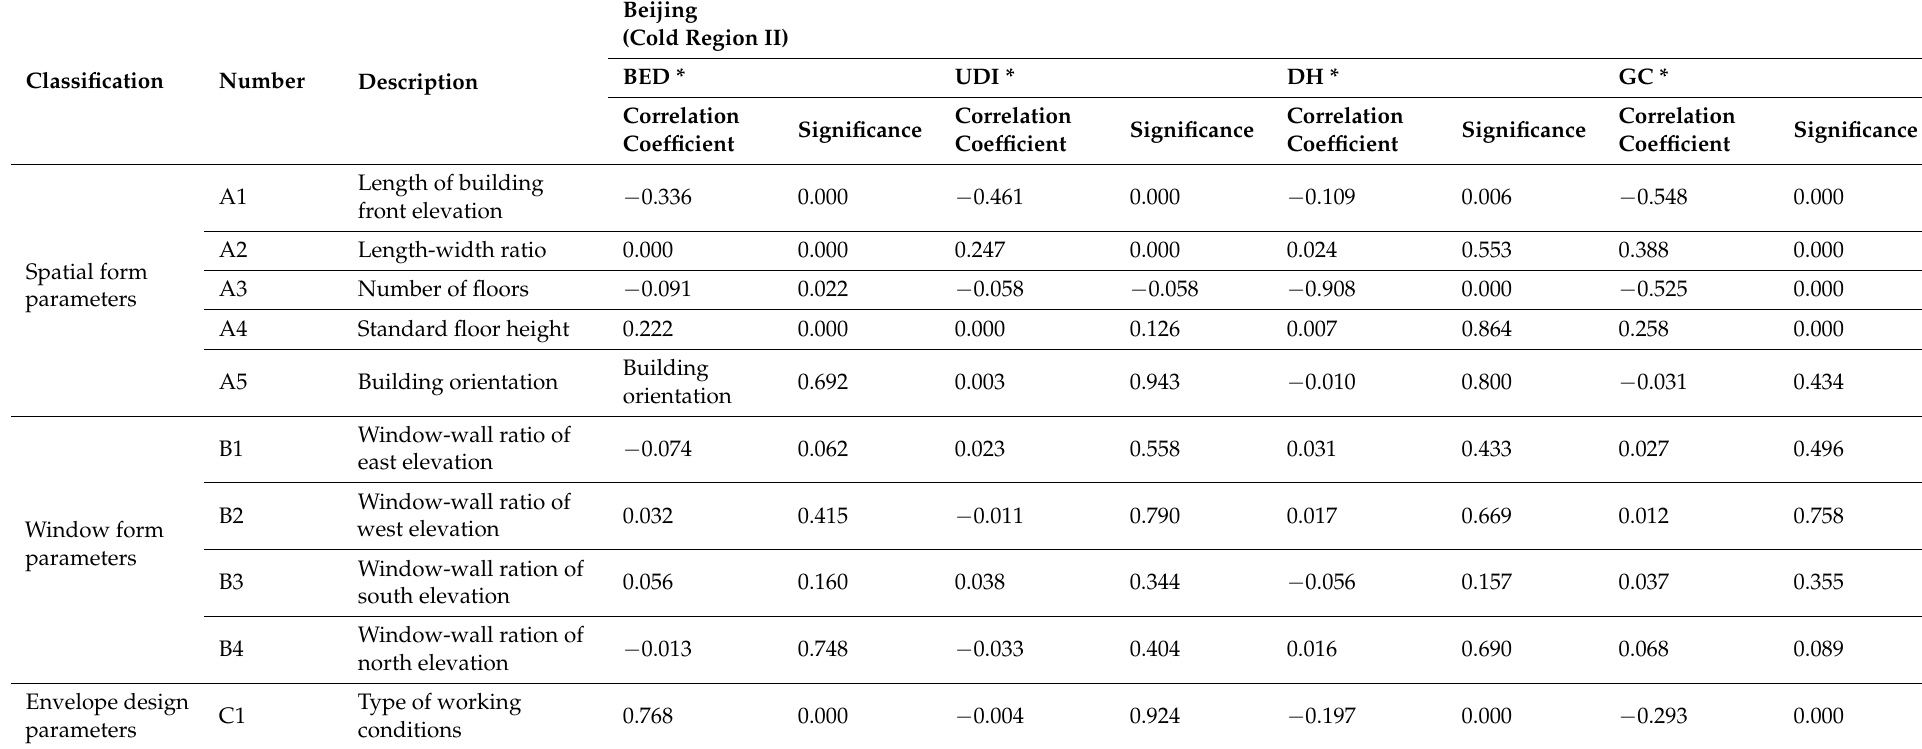
Table 9. Comparison of Spearman’s rank correlation coefficients for the design parameters of building forms in